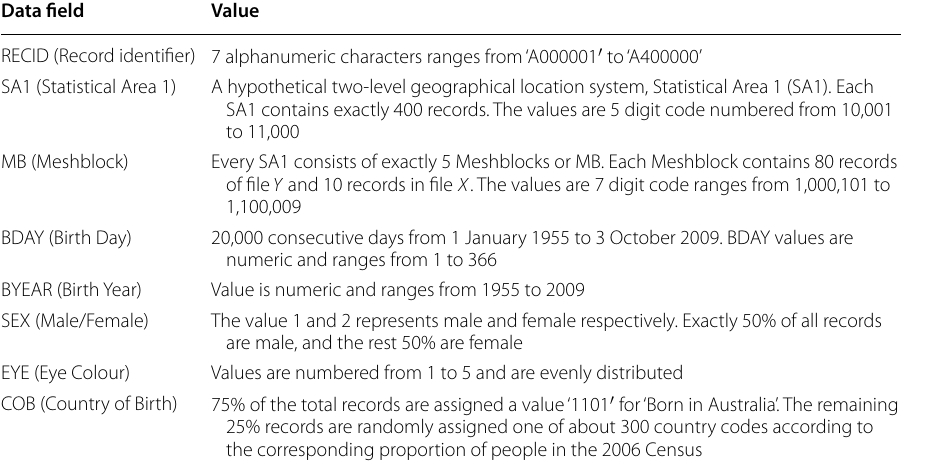
Table 1 Data field description Data